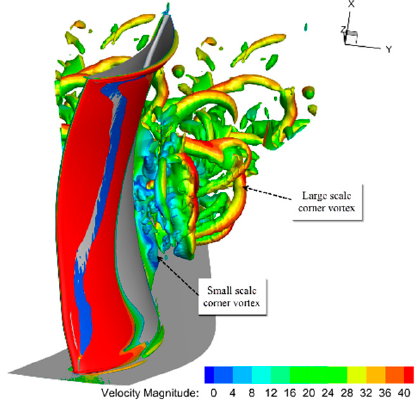
Figure 10. Isosurface of Q = 15,000,000.